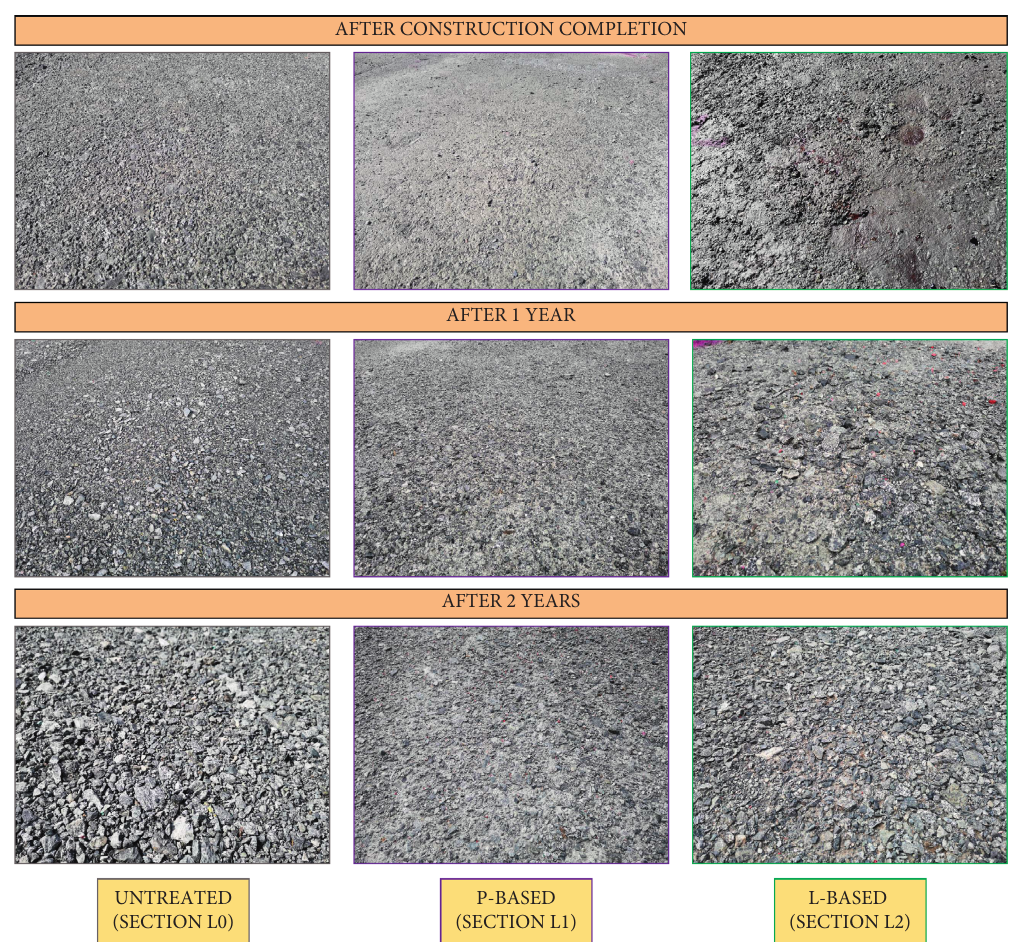
Figure 11: Surface appearance of the tested road sections during a two-year time span (the maximum size of the rock aggregates is 32